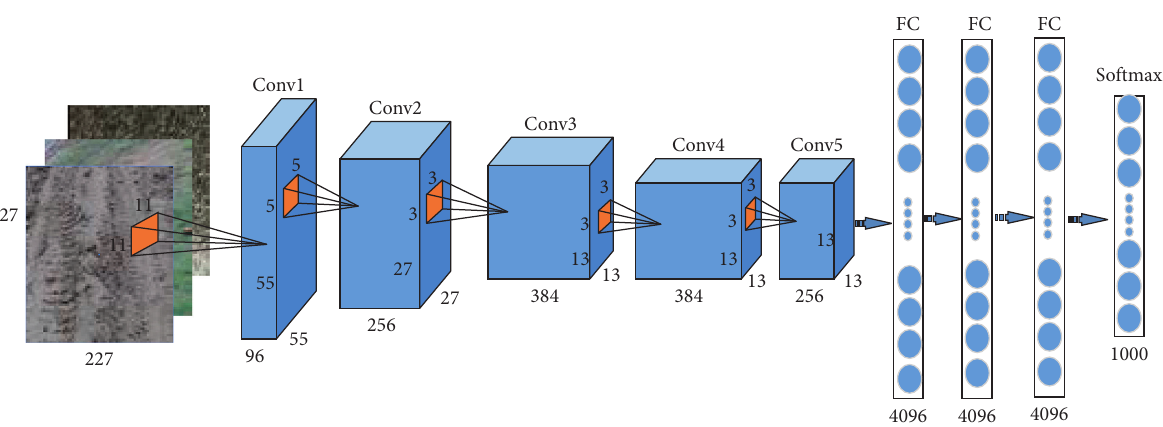
Figure 3: The structure of ALexNet network models. Table 1: ALexNet structure